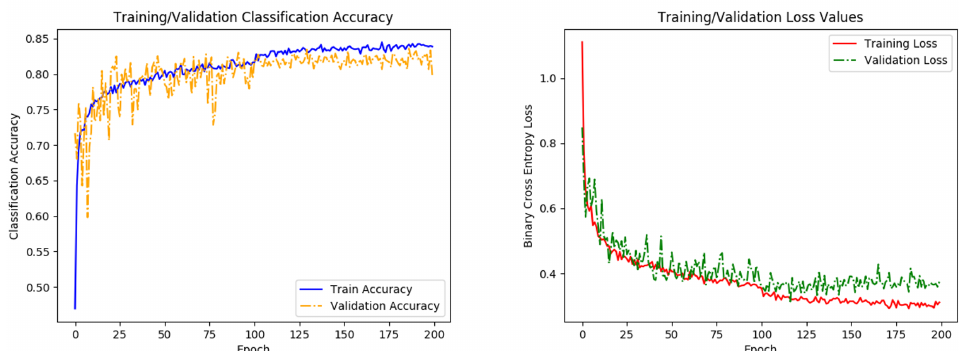
Figure 5. Graphs of network accuracy ( left ) and cross-entropy loss ( right ) for training and validation datasets. A small respective bump/dip in accuracy/loss is observed at 100 epochs, where the learning rate parameter is reduced. Training levels out before the 200 epochs, indicating that the network has finished